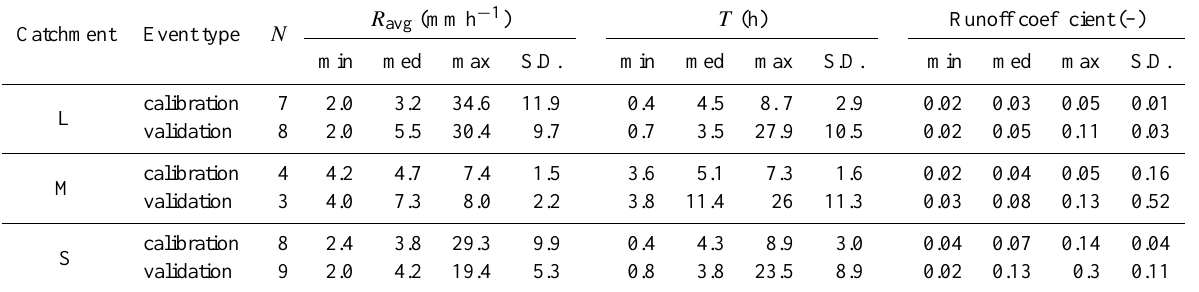
Table 9. Statistics of the calibration and validation events.